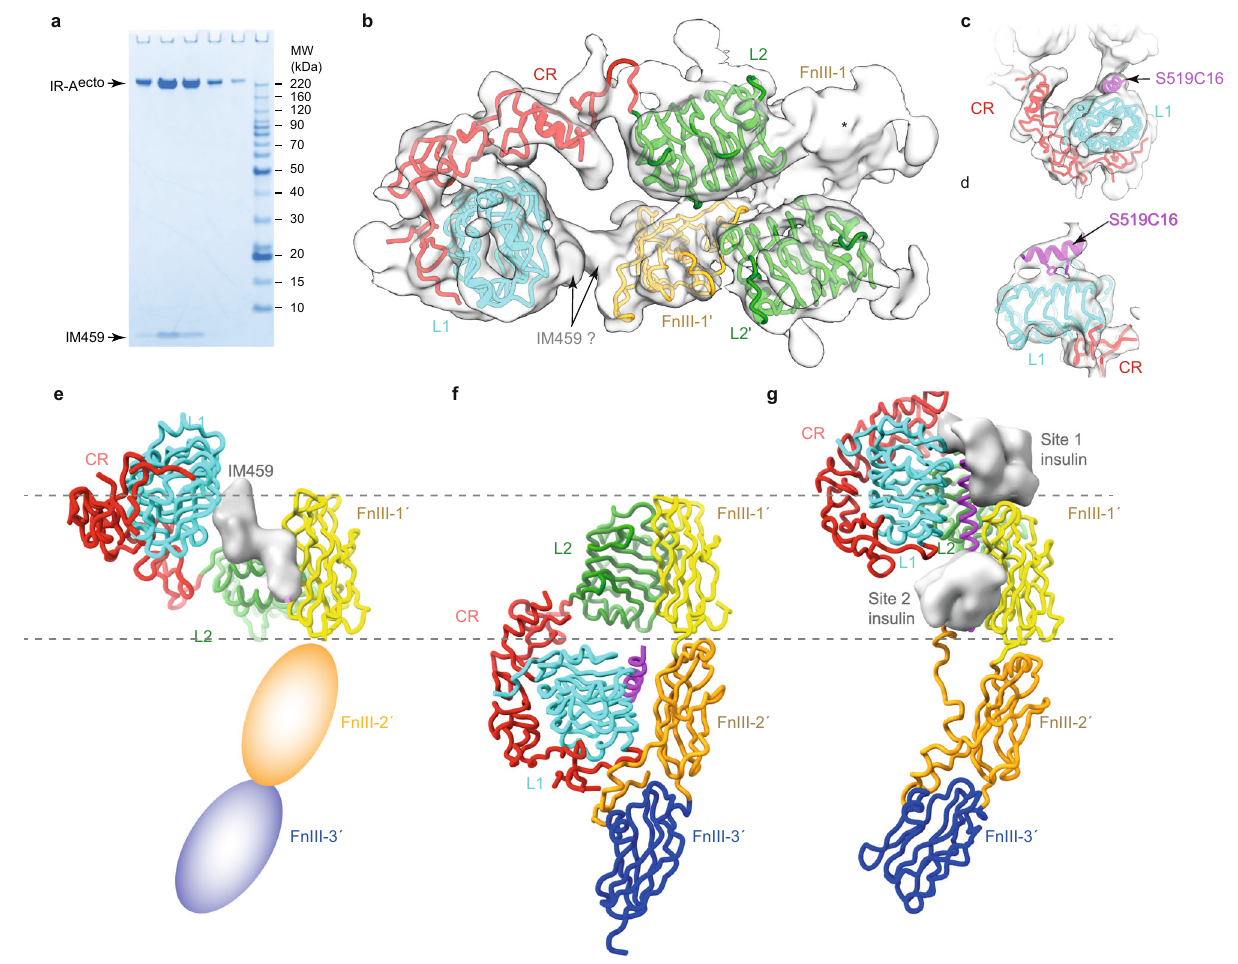
Fig. 2 | CryoEM structure of the IM459-bound hIR-A ecto . a NuPAGE 4-12% Bis - Tris gel (non-reducing conditions) of pooled fractions evidencing the presence of the IM459 peptide within the puri fi ed complex. This gel experiment was conducted n =1 times. b Focus-re fi ned cryoEM map showing the fi t of IR domains L1, CR, L2, FnIII-1 ′ , and L2 ′ and the residual density attributable to IM459; density corre- sponding to domain FnIII-1 is asterisked. c , d Map as in b, showing respective orthogonalviewsofthe rigid-body fi tof theco-complexof S519C16and thehIR L1-